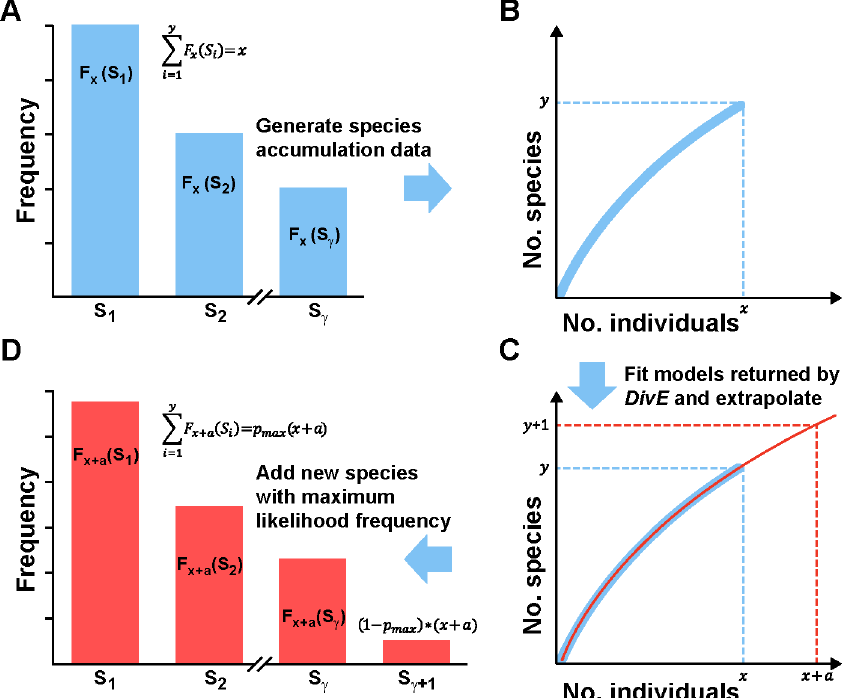
Figure 2. Outline of DivE distribution generation algorithm. A Truncated species frequency distribution with x individuals distributed among y species. The frequency of species S i after sampling x individuals is denoted F x (S i ) . B Species accumulation data generated from frequency distribution. C An aggregate of the best performing models as returned by DivE is used to extrapolate to point (x + a, y + 1) , where the next species is predicted. D Species S y + 1 is assigned a frequency of (1 - p max )(x + a) , where p max is the maximum-likelihood proportion of individuals occupied by the y previously observed species. The remaining p max (x + a) individuals are distributed among species S 1 , …, S y in proportion to their observed relative frequencies at x . Steps C and D are repeated until the predicted species richness is reached. See Text S1 for further details.